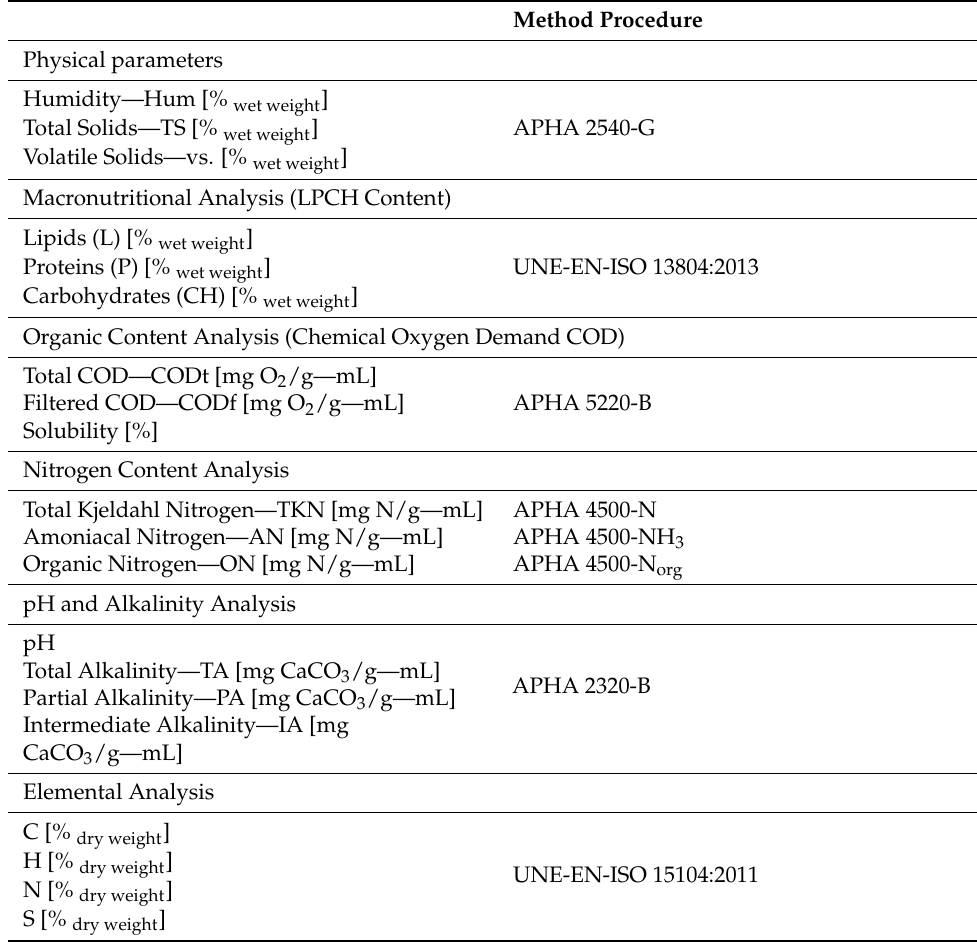
Table 1. Standardized procedures used for compositional characterization of substrates and